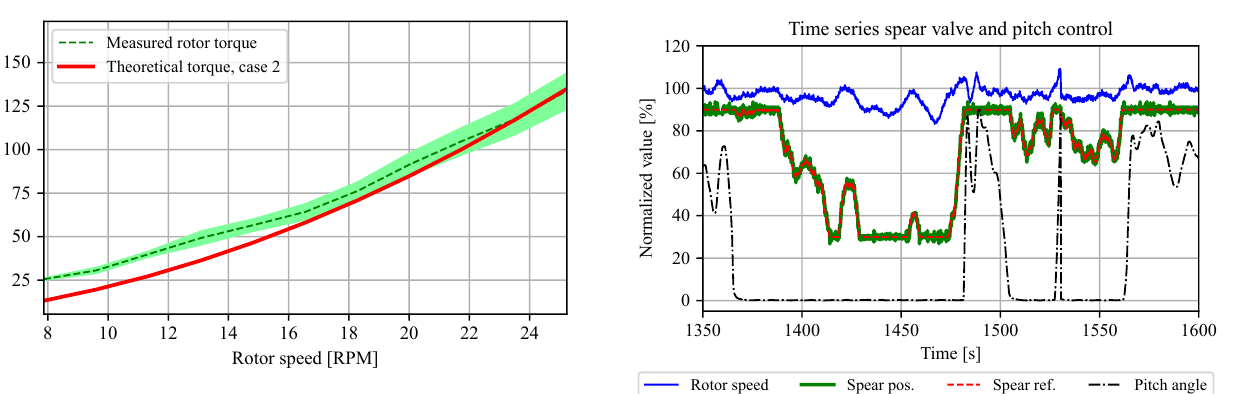
Figure 22. Evaluation of the passive torque control strategy by comparison of the theoretical torque for case 2 to the torque mea- sured by load pins in the oil pump suspension. For higher speeds, the passive torque control strategy succeeds in near-ideal tracking of the desired case 2 path. At lower rotor speeds, the torque is higher than the aimed theoretical line as a result of the lower combined drivetrain efficiency in this operating region.